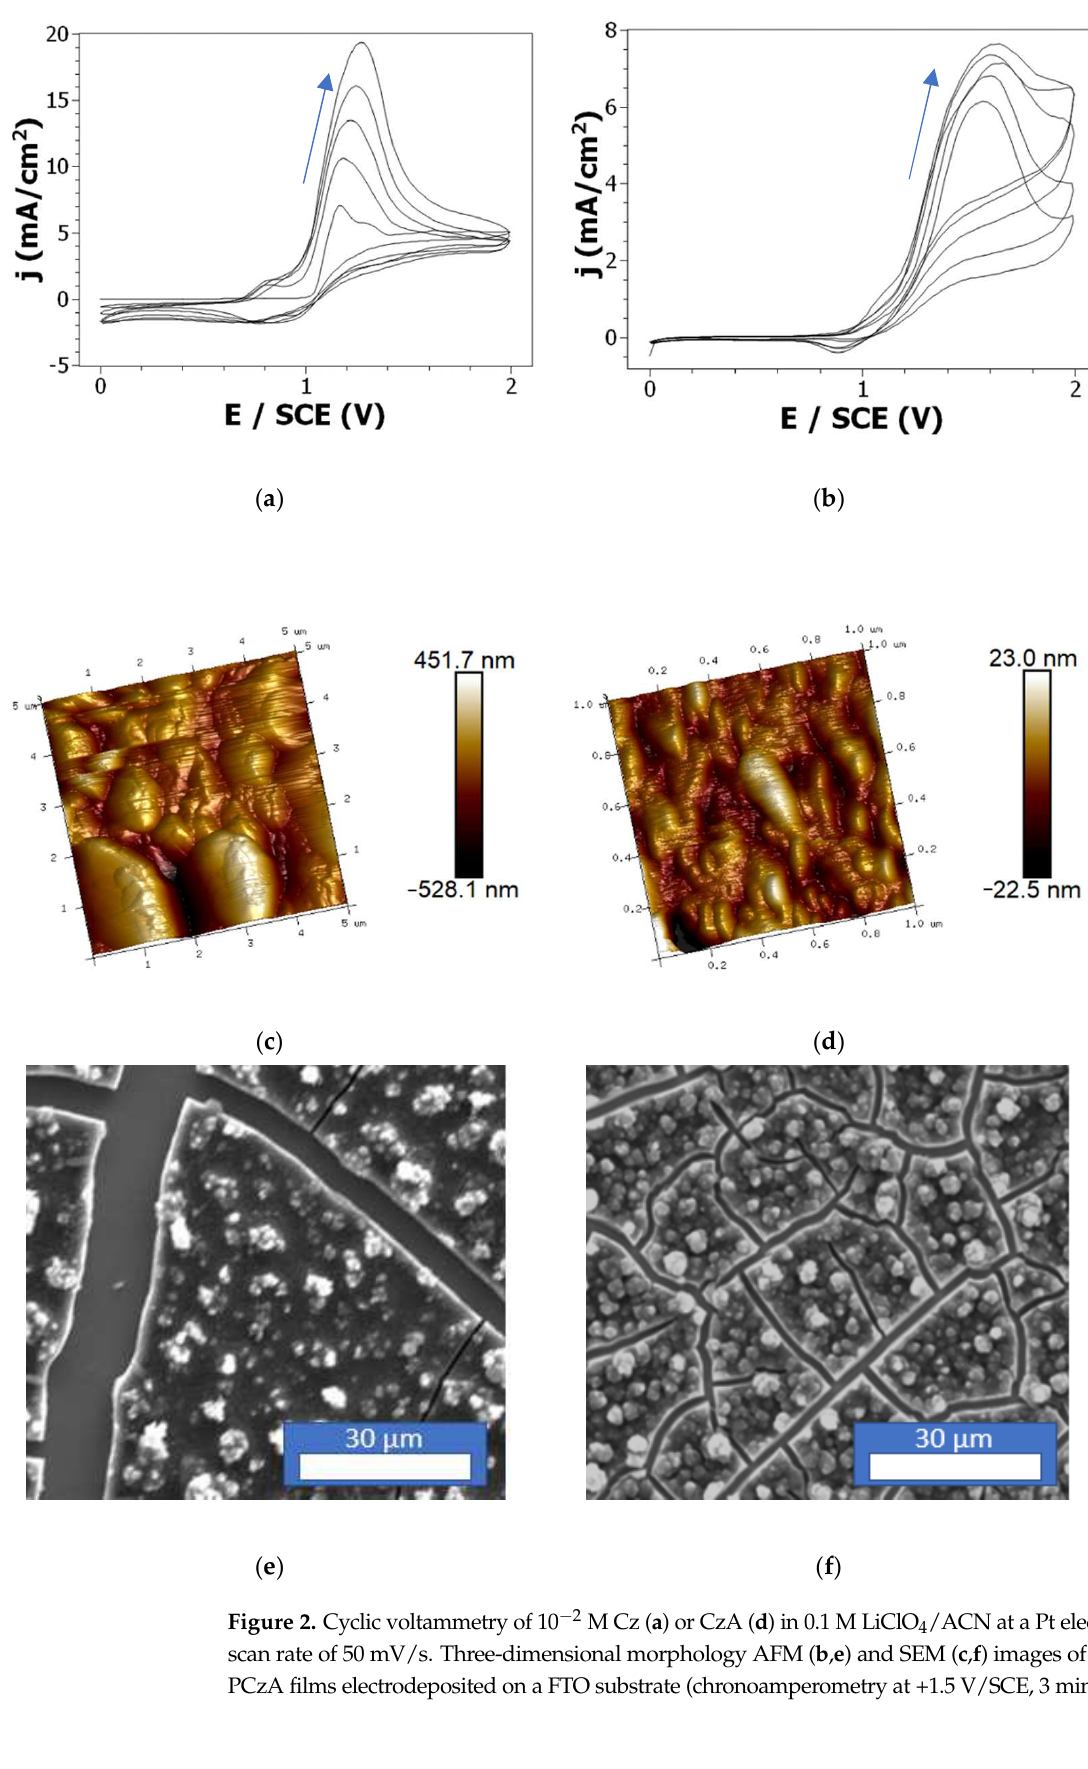
Figure 2. Cyclic voltammetry of 10 −2 M Cz ( a ) or CzA ( d ) in 0.1 M LiClO 4 /ACN at a Pt electrode with a scan rate of 50 mV/s. Three-dimensional morphology AFM ( b , e ) and SEM ( c , f ) images of the PCz and PCzA films electrodeposited on a FTO substrate (chronoamperometry at +1.5 V/SCE, 3 min).